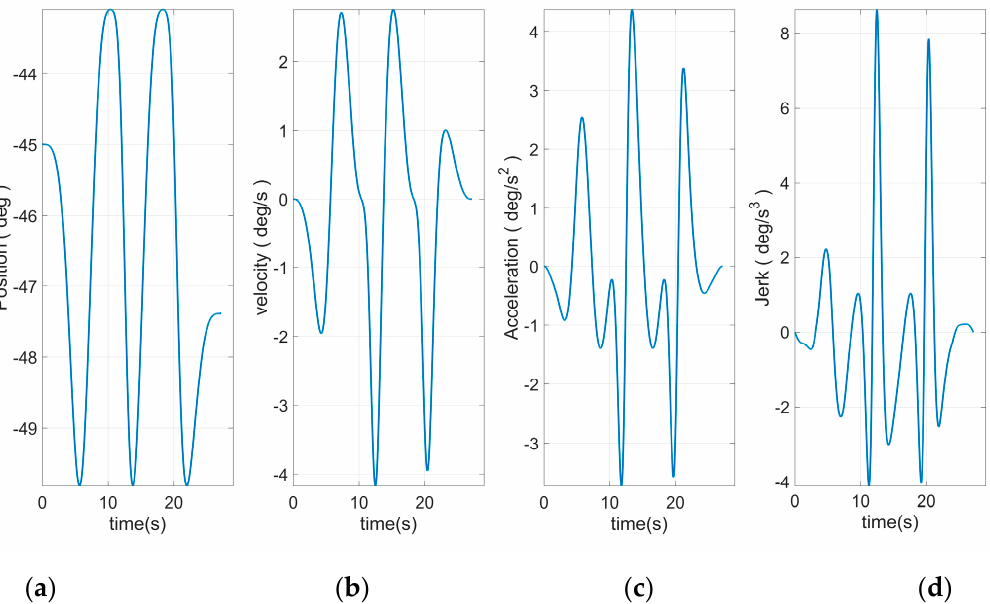
axis IV over time. ( d ) Jerk of